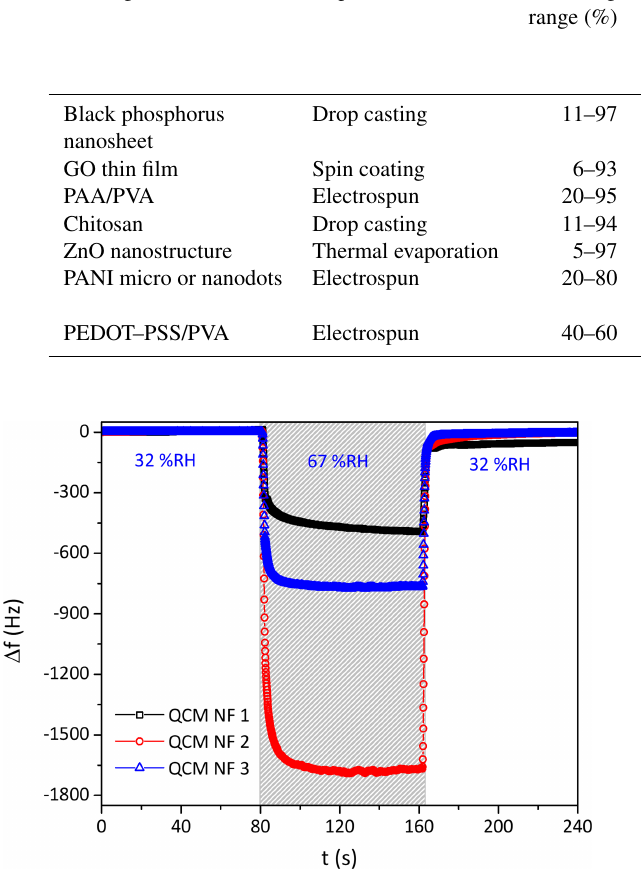
Figure 5. One cycle of the dynamic response of the PEDOT– PSS/PVA nanofiber QCM humidity sensor.